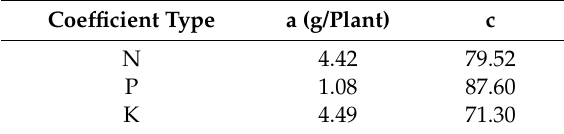
Table 5. The coefficient values of SAN uptake